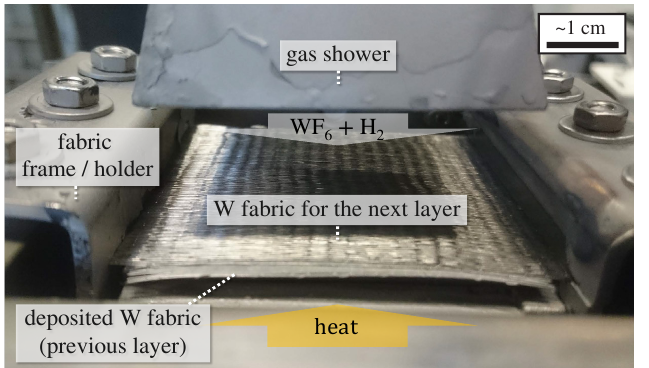
Figure 1. Picture of a W f /W production step: a fabric mounted on a previously coated fabric layer grown on the heating table inside of the CVD